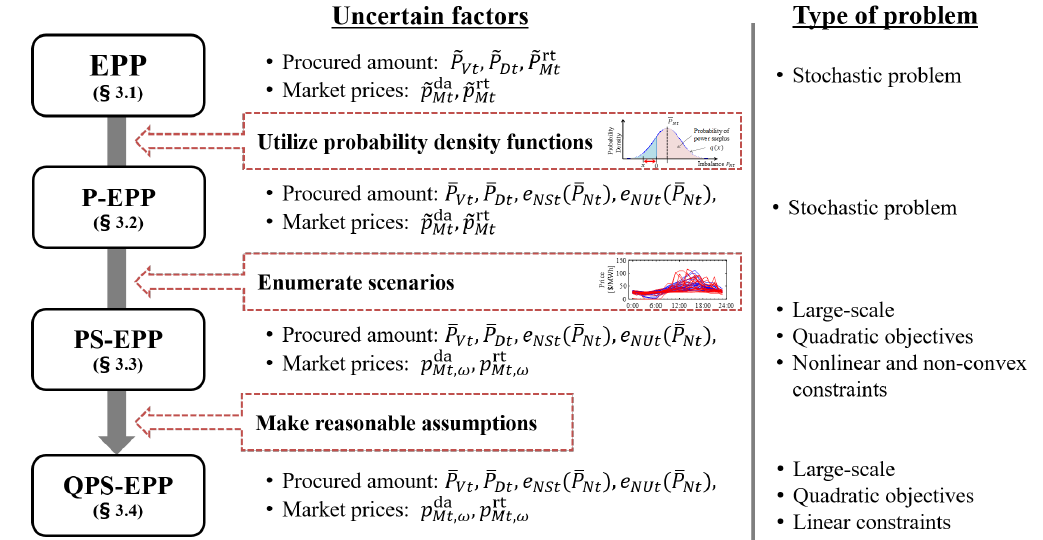
Figure 2. Procedure to transform and relax the energy procurement problem (EPP). P-EPP, probabilistic EPP; PS-EPP, probabilistic and scenario-based EPP, QPS-EPP, quadratic probabilistic and scenario-based